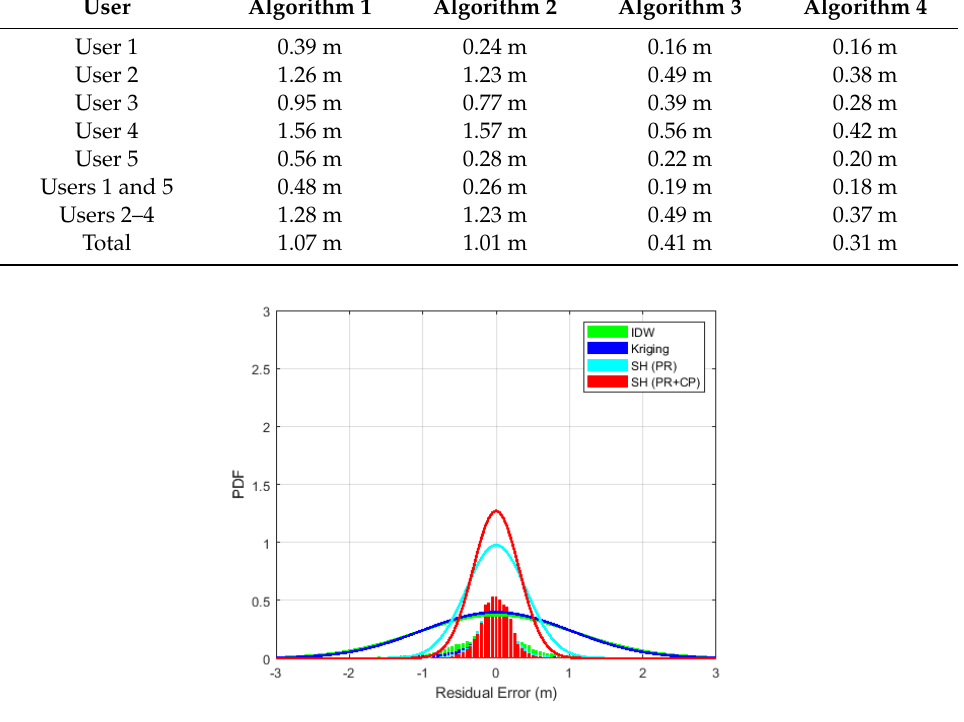
Figure 14. Probability distribution function for the residual error of each algorithm (real data, 1 September 2014).